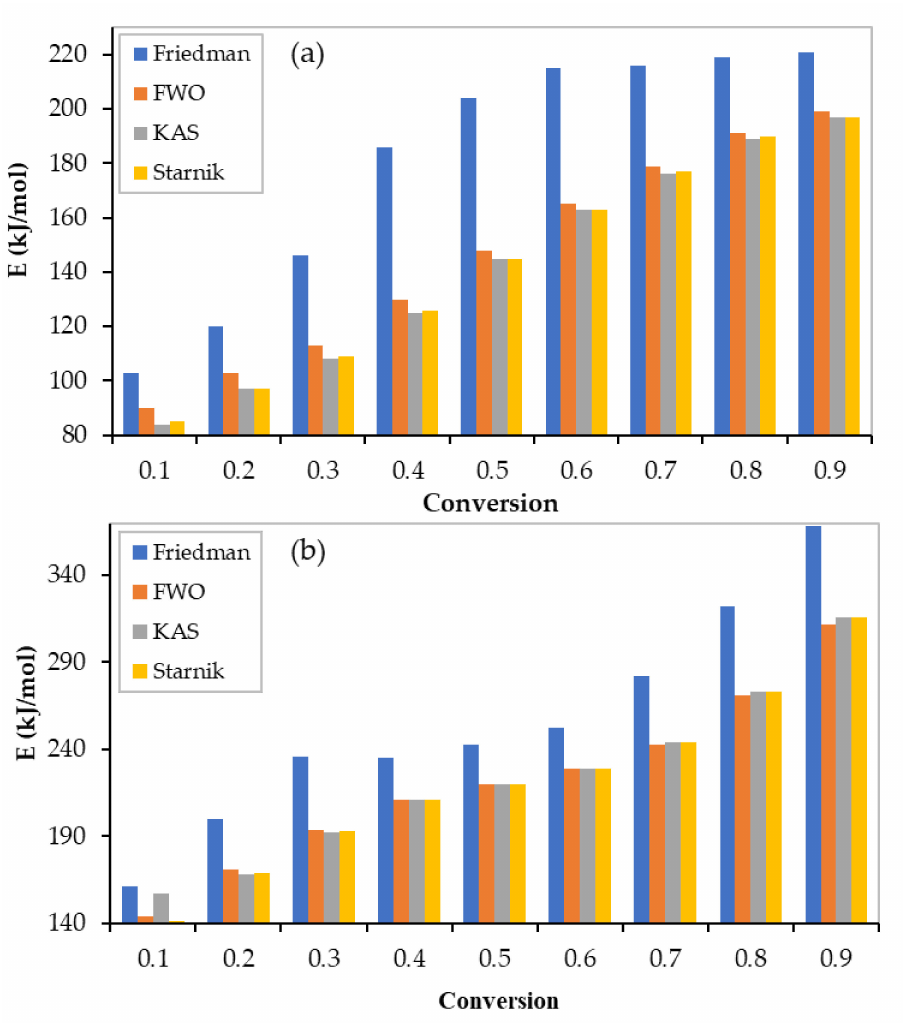
Figure 5. Activation energies obtained by different model-free models: ( a ) binary mixtures; ( b ) ternary mixtures. Table 7. Kinetic parameters of the pyrolysis of plastic mixtures by Coats–Redfern model (tests 1–3). Reaction